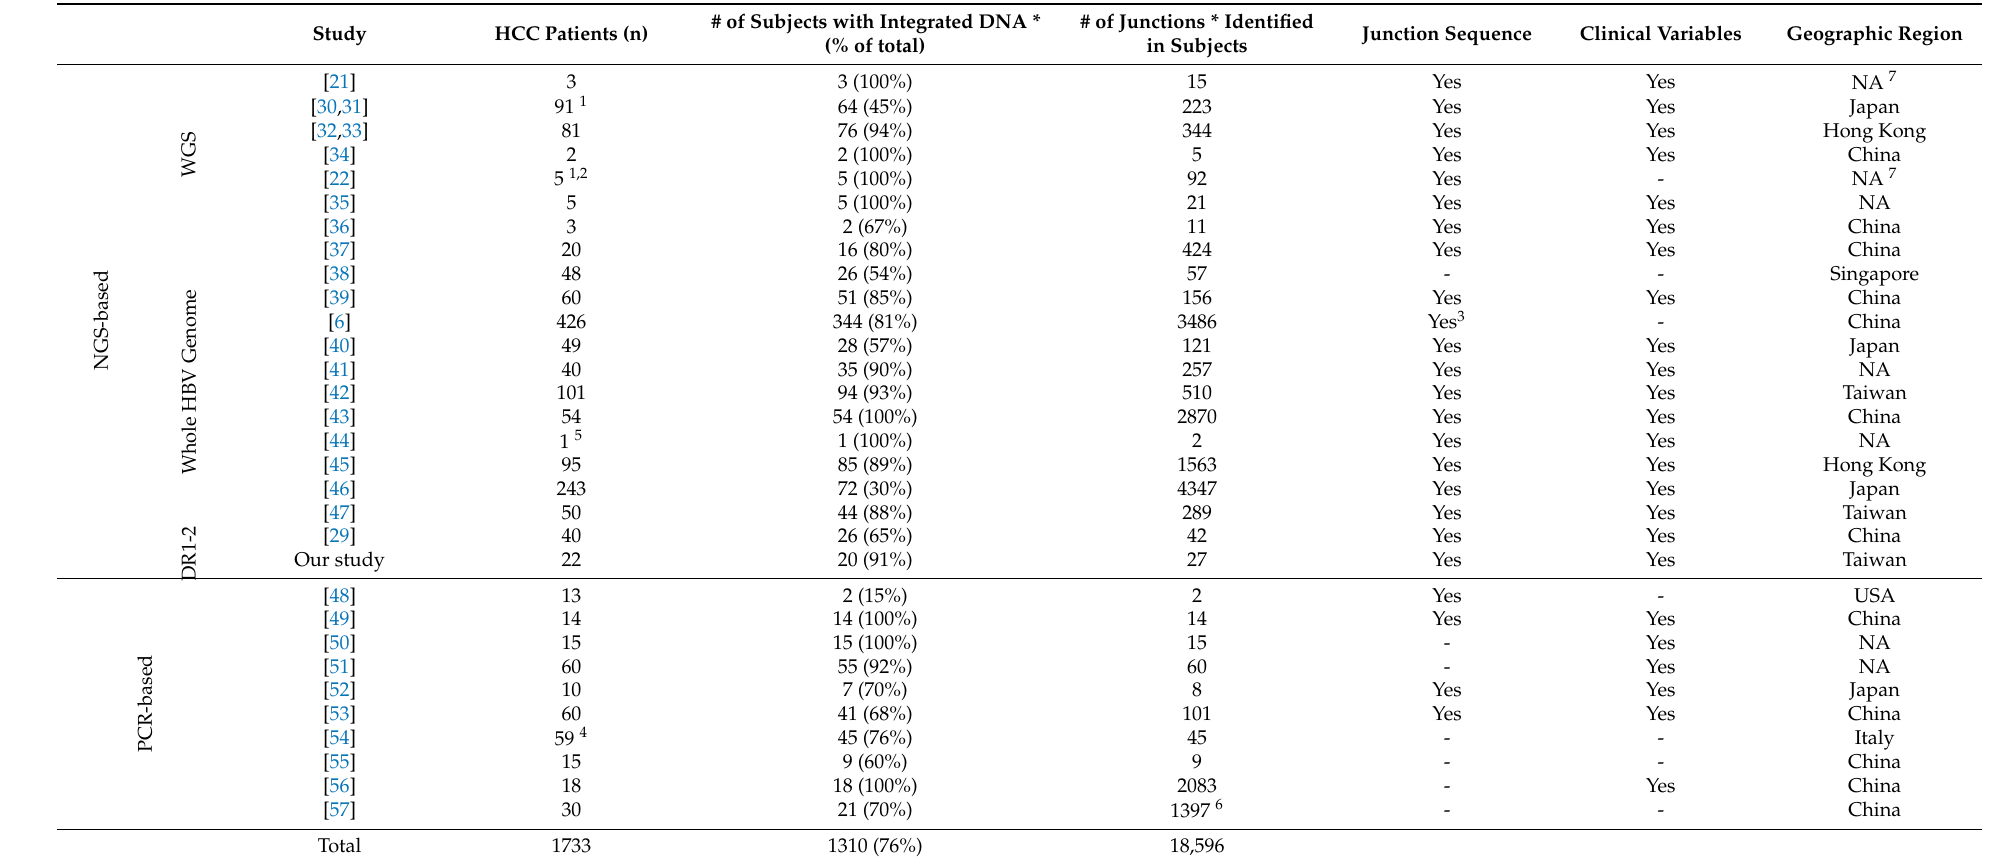
Table 1. Summary of HBV integration studies included in this